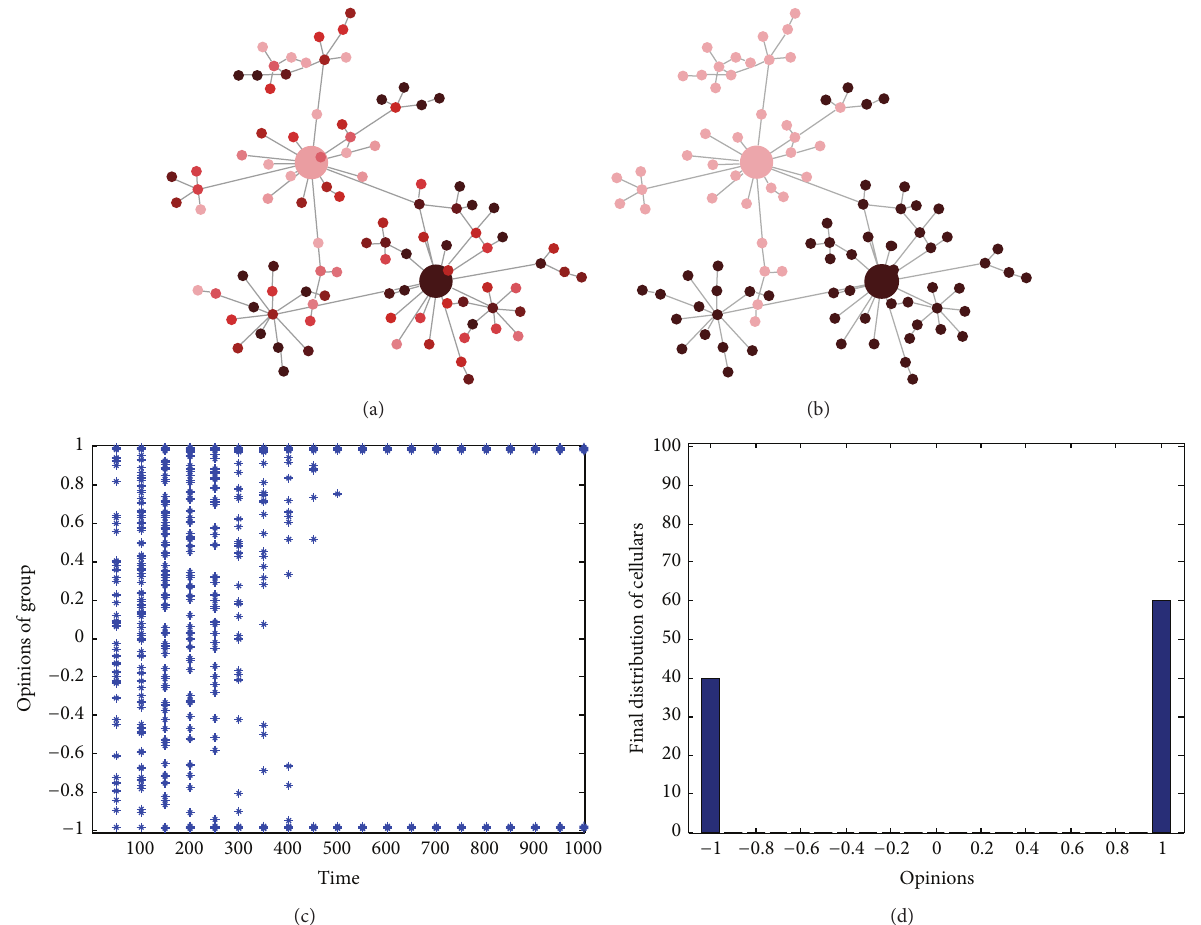
Figure 15: When 𝑎 = 0.7 , 𝑏 = 0.3 , and 𝑐 = 0 , two opinion leaders influence the polarization of Internet group opinions. (a) Opinions distribution at 100 time steps; the opinion of two opinion leaders is − 0.6 and 0.8, respectively. (b) Opinions distribution at 1000 time steps; the opinion of two opinion leaders changes to − 1 and 1, respectively. (c) Opinions of group change with time when there are two opinion leaders. (d) Histogram of final distribution of group opinions.